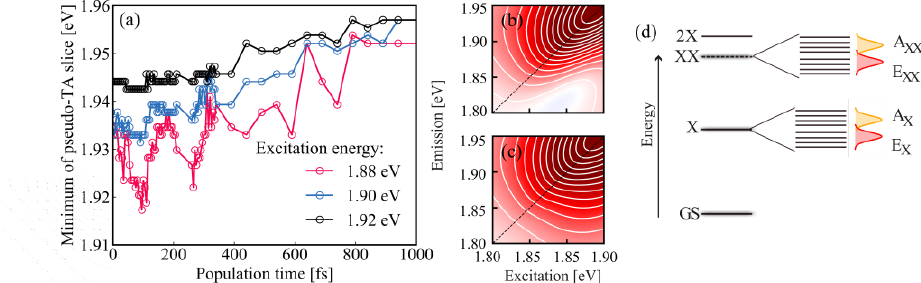
Fig. 3. (a) Minimum position of the spectral projections shown in Fig. 2.(a) as a function of population time for different excitation energies. Aside from blue shifting, the traces oscillate at the LO phonon frequency due to exciton-phonon coupling. (b) Computed 2D spectra including sample heterogeneity and multiple XX states. Parameters: inhomogeneous broadening σ inhomo =40 meV, homogeneous linewidth  homo =30 meV, and Δ XX = 65 meV. The spectrum qualitatively matches the experimental spectra at early population times. (c) Same as in (b) but with Δ XX = 10 meV, matching the experimental spectra at later population times. (d) Updated structure for the biexciton states including a fine structure, just like within the single exciton